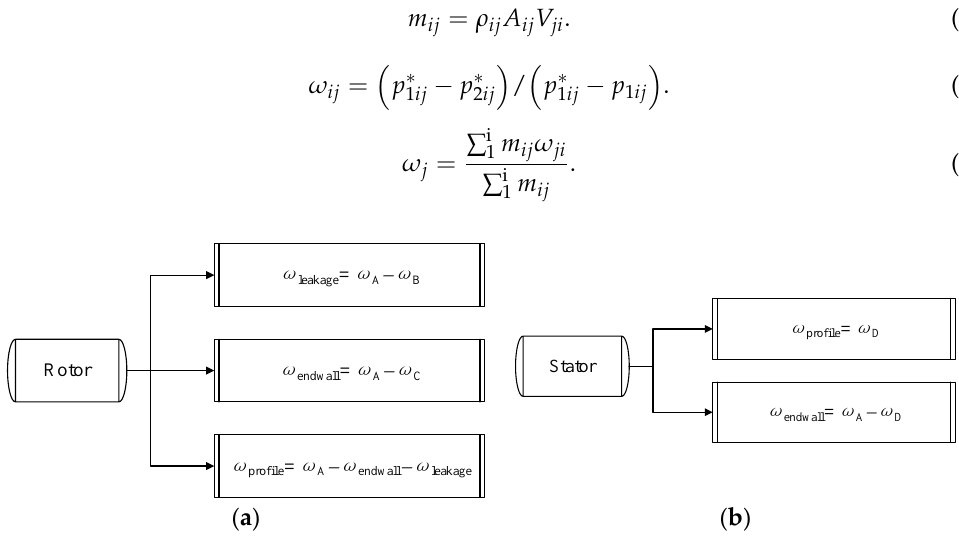
Figure 14. Loss decomposition process for the compressor stages: ( a ) rotor; ( b )